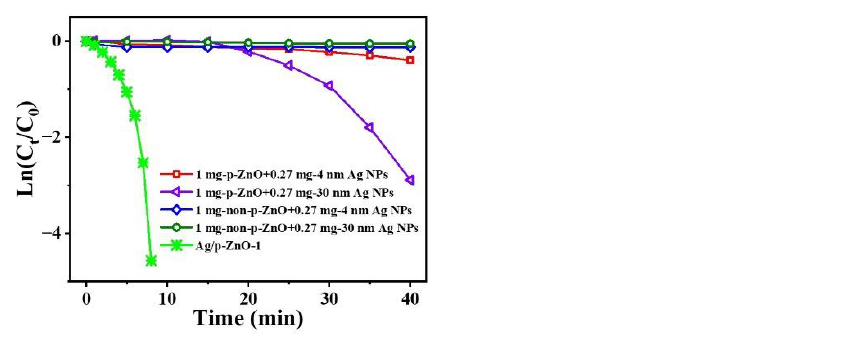
Figure 6. Plots of Ln(C t /C 0 ) versus the reaction time for the reduction of 4-NP over different catalysts under natural light. under natural